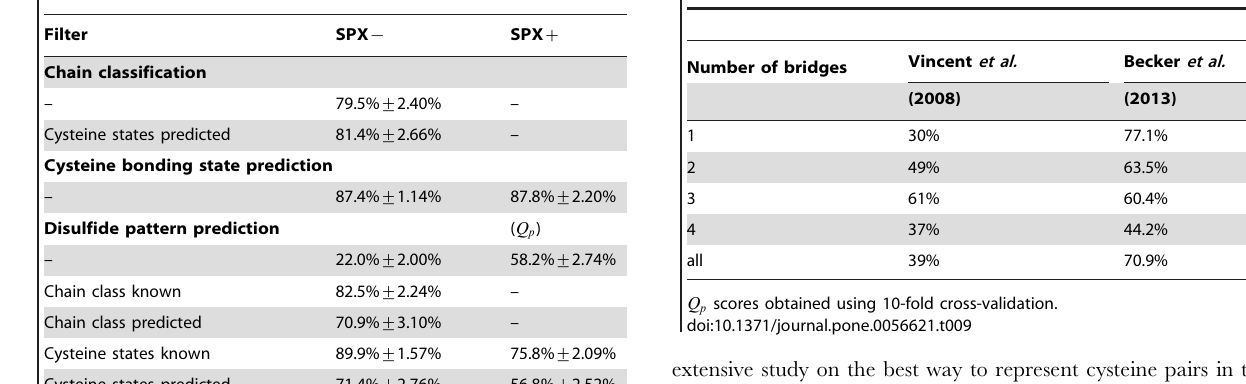
Table 8. Evaluation of the three tasks. Table 9. Comparison of Q p scores on SPX { when chain classes are